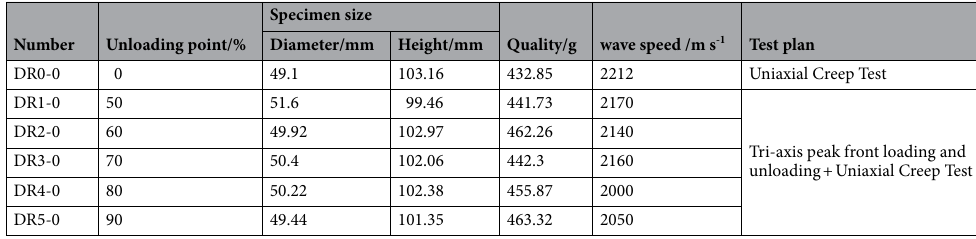
Table 1. Details of prepared rock samples.